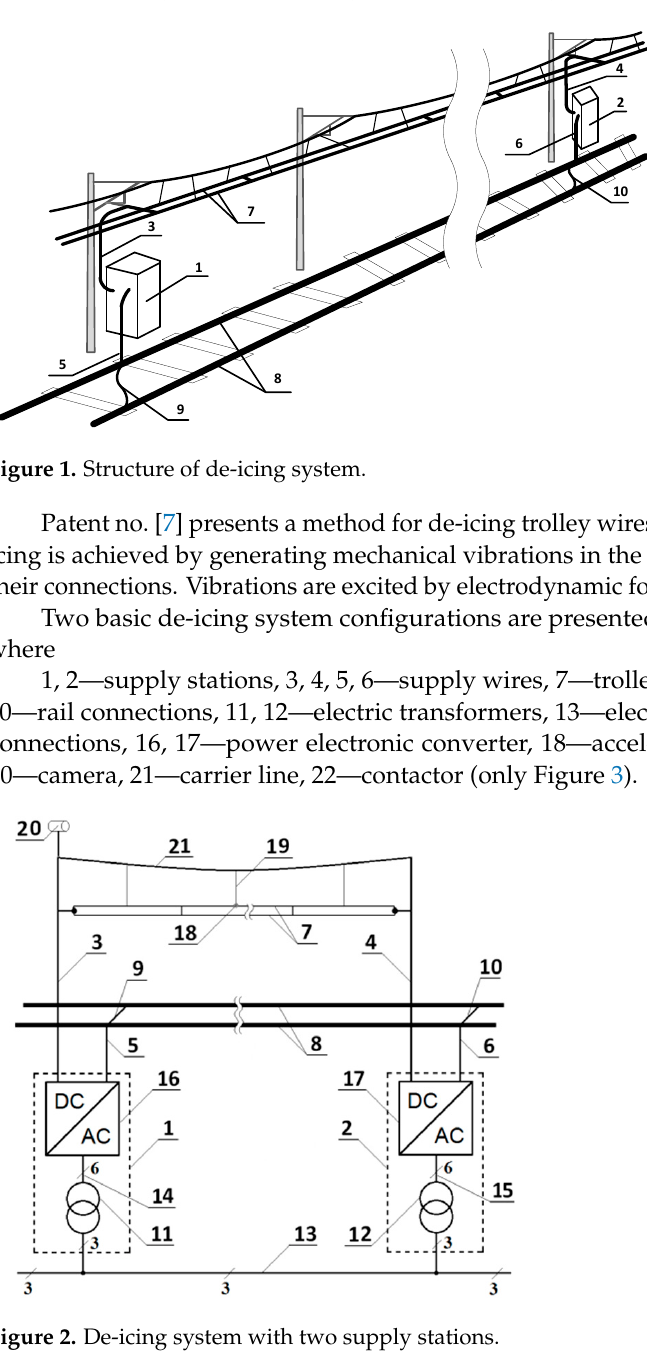
Figure 1. Structure of de-icing system.